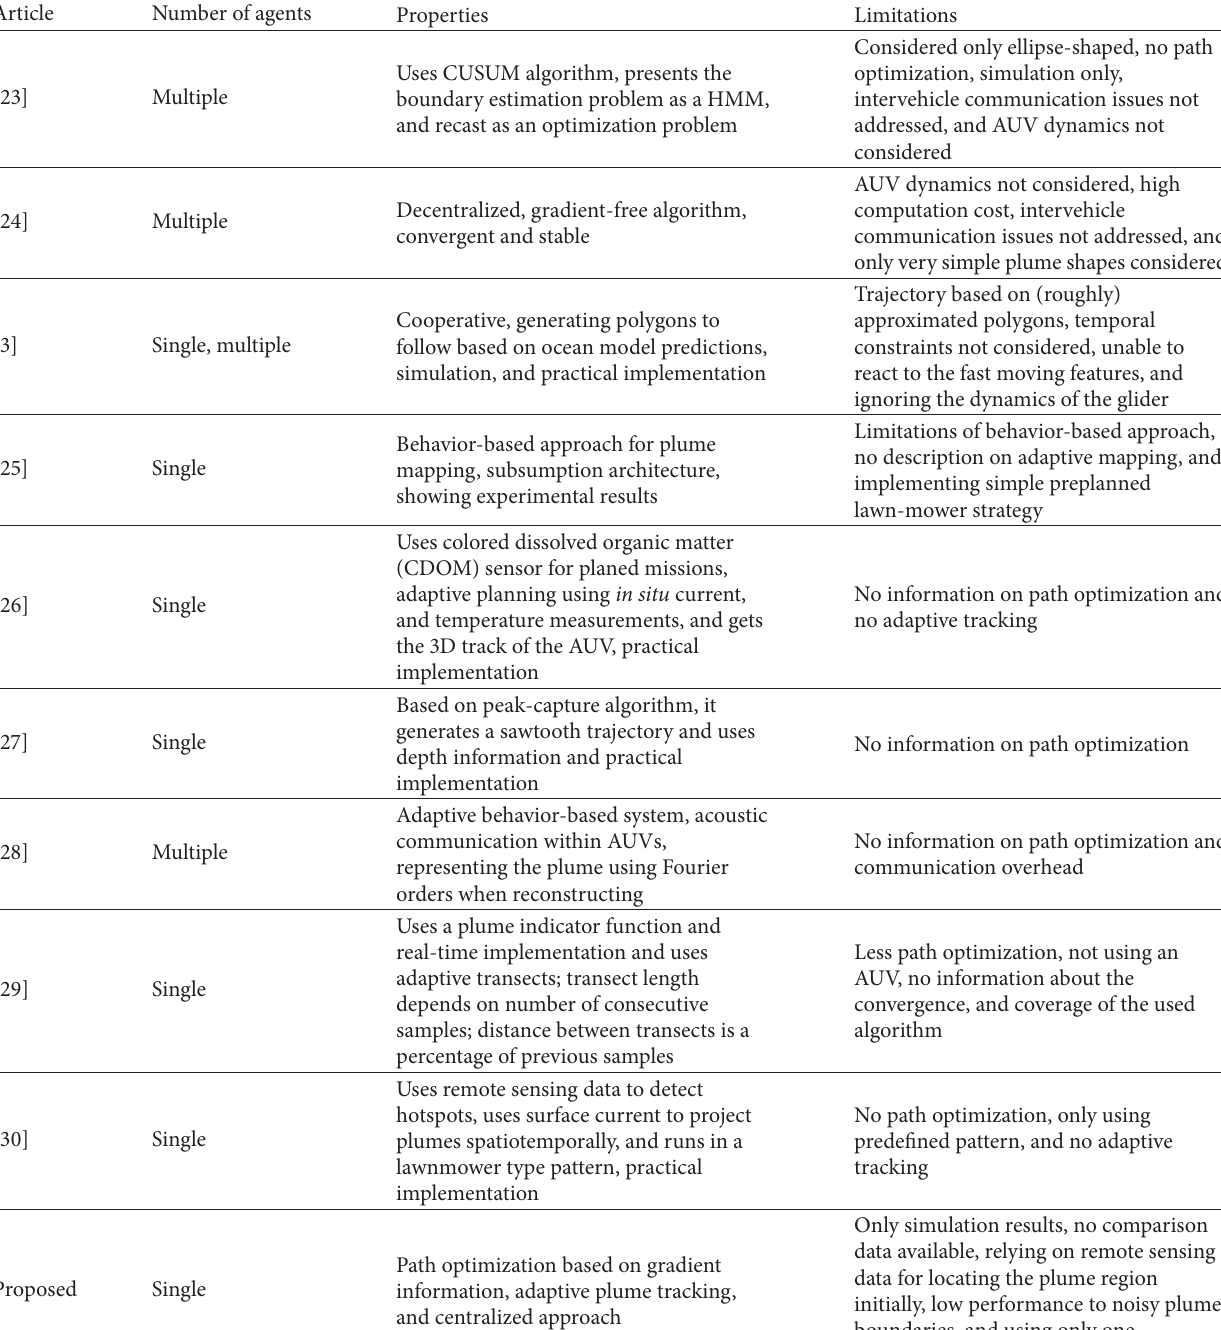
Table 2: Different plume tracking strategies in